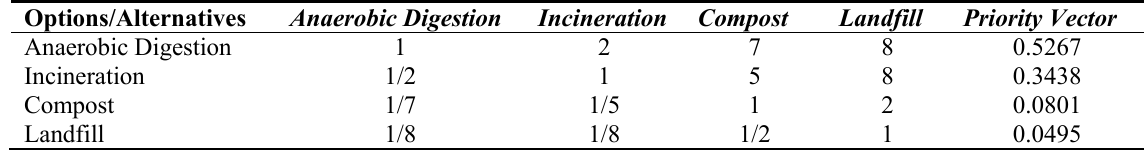
Table 7. Pairwise comparison matrix for the options with regards to economic criteria.